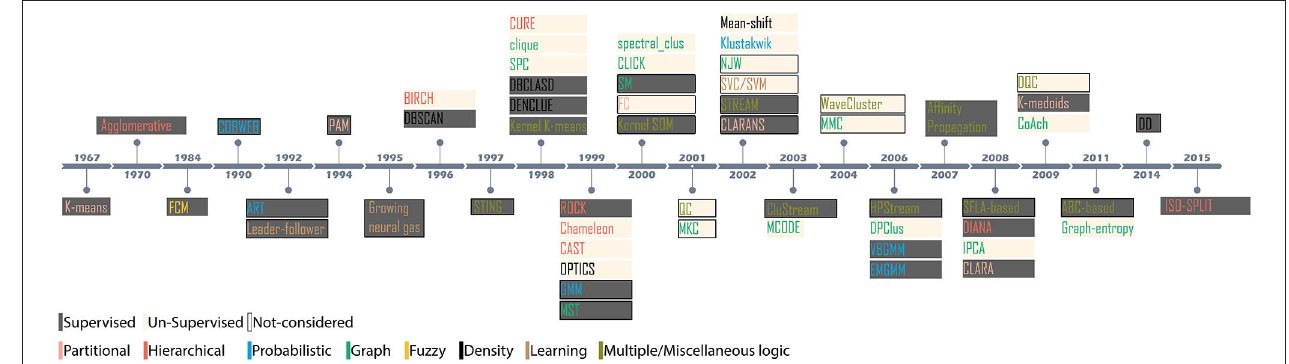
FIGURE 2 | Evolution of novel clustering algorithms since 1967. The shaded region indicates the methodology; supervised or unsupervised for the clusters considered in the context, and the colored text indicates the category of the clustering